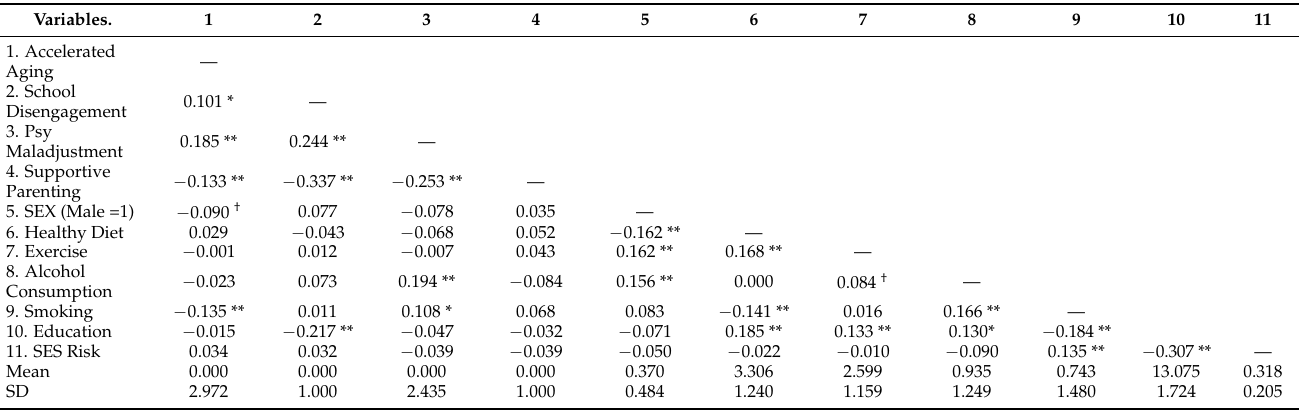
Table 1. Correlation, Mean, and Standard Deviations for the Study Variables ( n = 386).